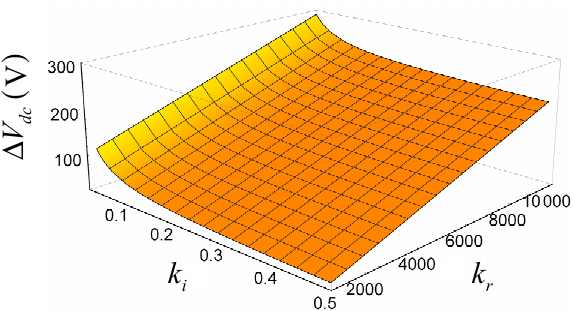
Figure 6. Relationship between DC-link voltage deviation and frequency deviation under different parameters.